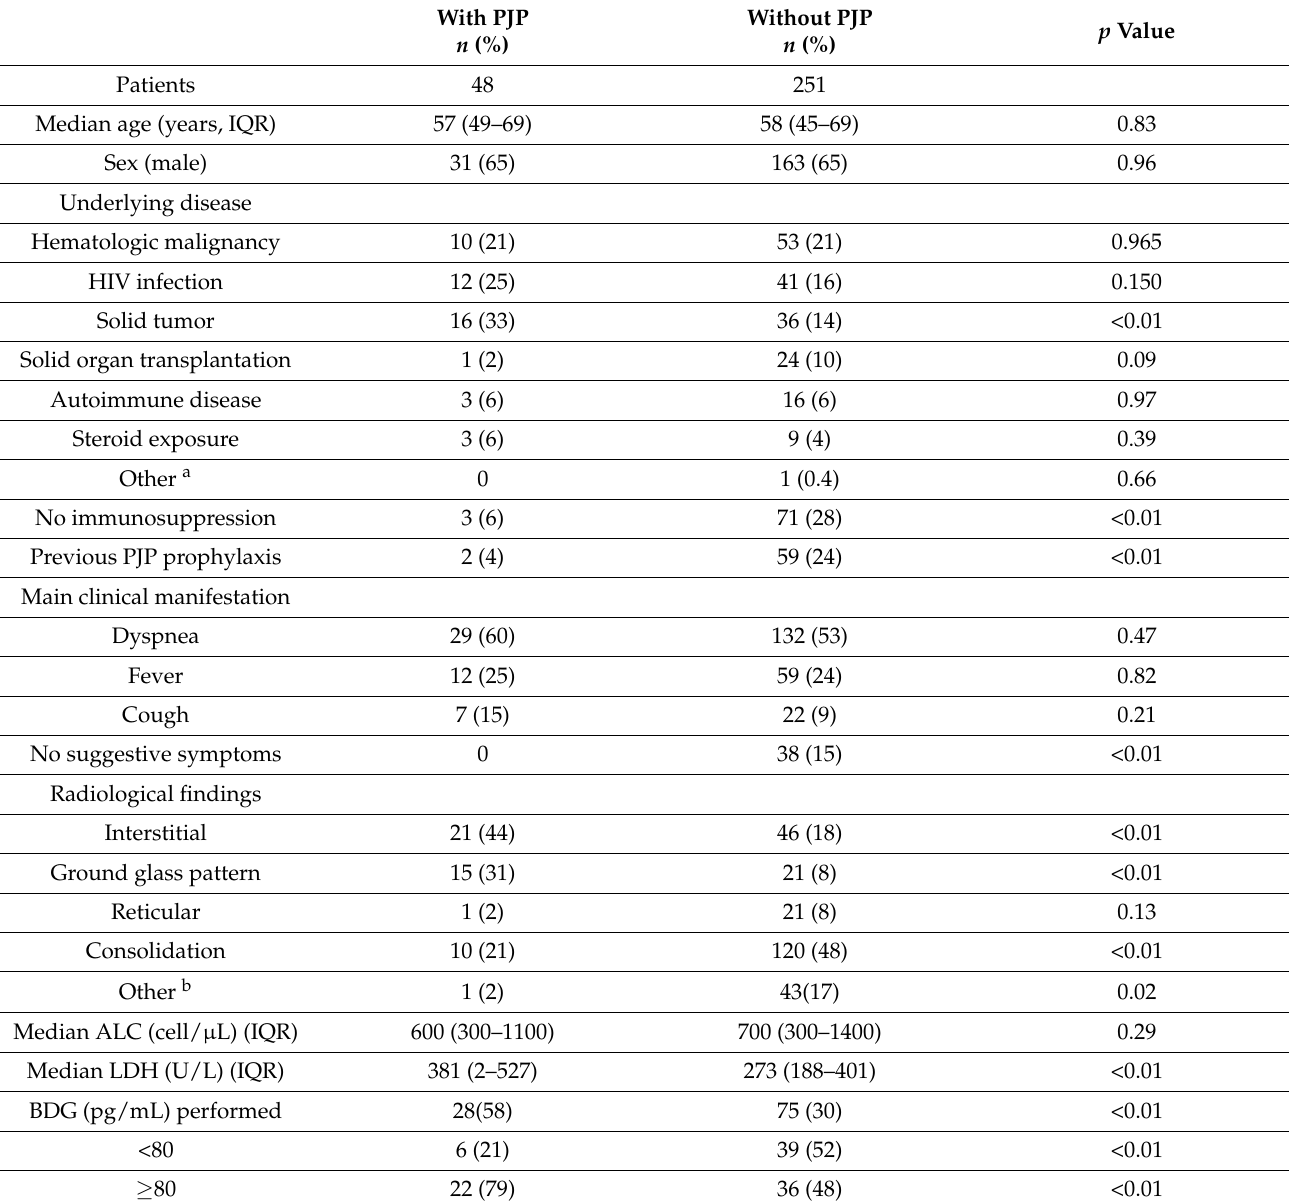
Table 1. Clinical characteristics of the patients stratified by the presence of P. jirovecii